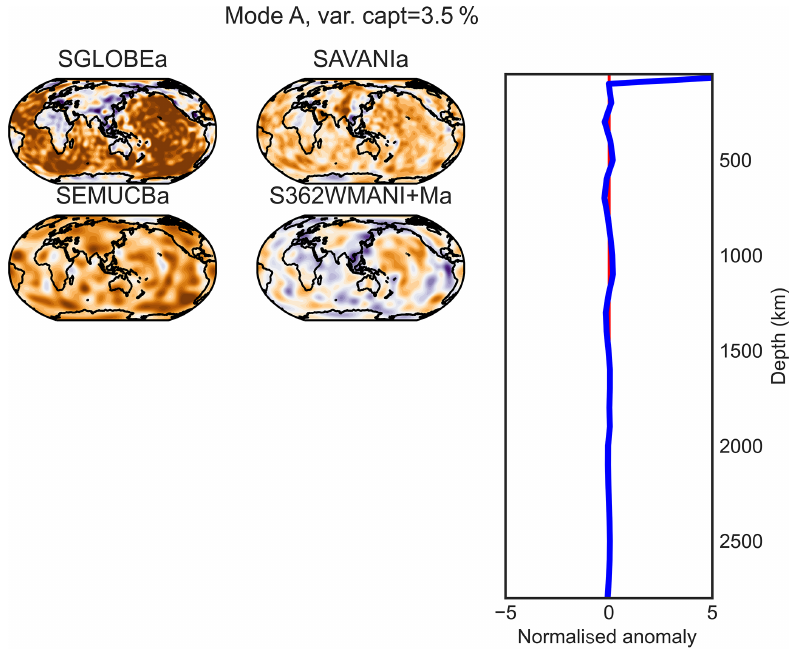
Figure E1. PC A (maximum at 50km of depth) of the combined analysis of the anisotropic parts of the models. On the right are the principal components or vertical profiles, and on the left are the associated horizontal structures.